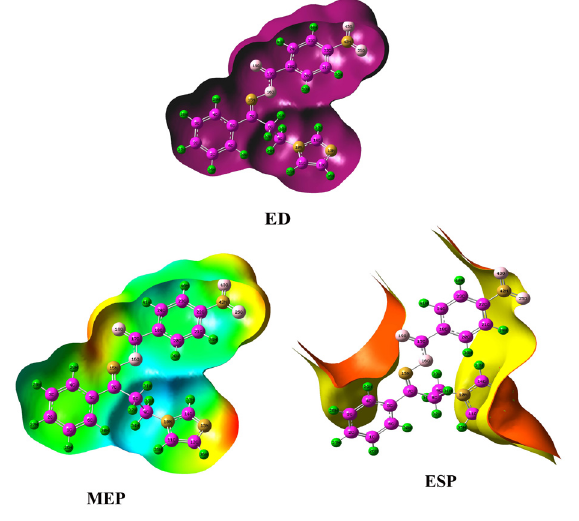
Figure 6: Electrostatic potential (ESP), electron density (ED) and the molecular electrostatic potential map (MEP) for the IPAONM molecule.